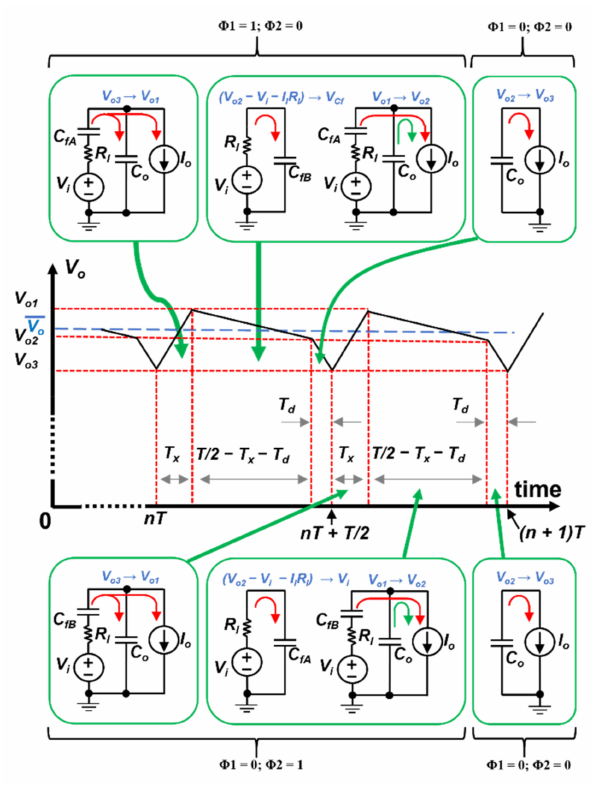
Figure 7. Output waveform and corresponding RC circuits of dual-branch 1-stage linear charge pump/cross-coupled voltage